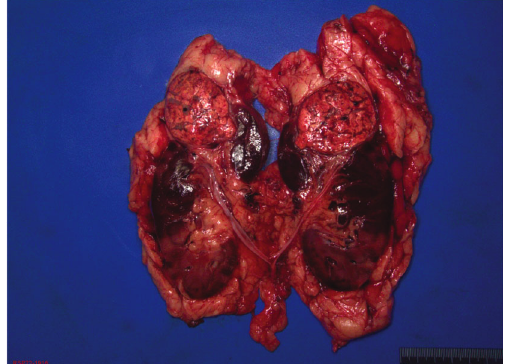
Figure 5: Gross pathology showing left kidney with upper pole renal mass, perinephric fat, and proximal ureter en